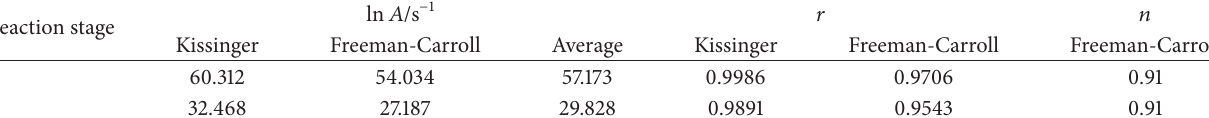
Table 4: Calculated results for the complex kinetic parameters using Kissinger and Freeman-Carroll methods. Reaction stage